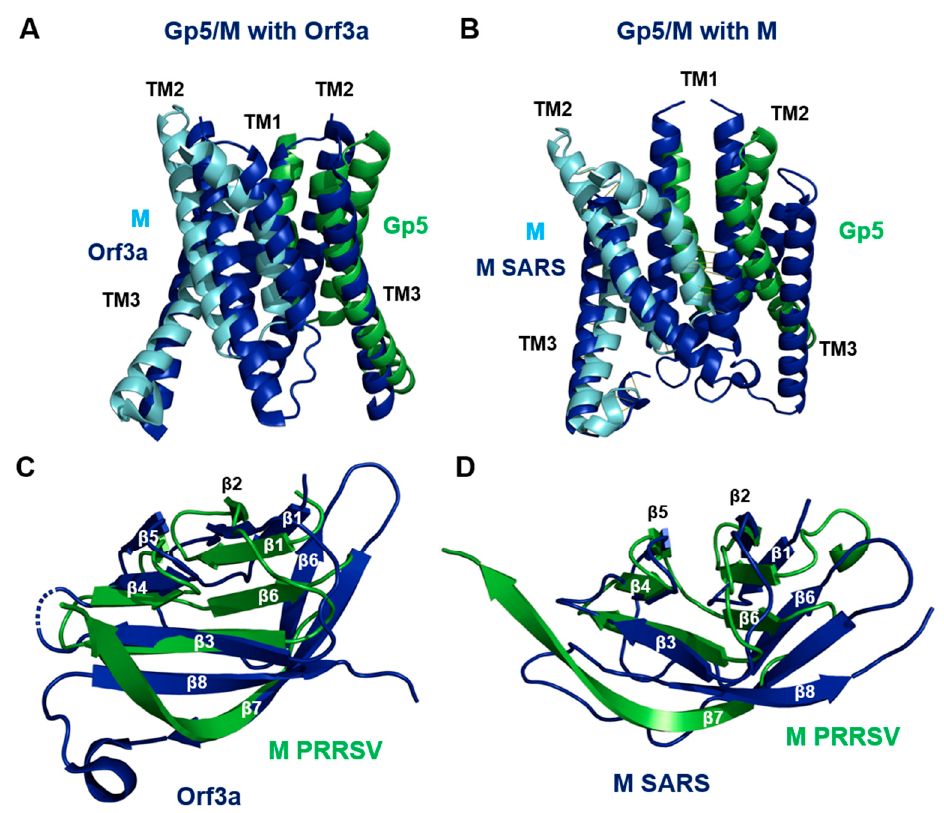
Figure 9. Alignment of the transmembrane regions of Gp5/M of PRRSV-2 with Orf3a ( A ) and with the long form of M ( B ) of SARS-CoV-2. Gp5 is colored green; M is colored cyan; and Orf3a and M of SARS-CoV-2 are colored blue. ( C , D ) Alignment of the endodomain of M of PRRSV-2 with one endodomain of Orf3a ( C ) or M ( D ) of SARS-CoV-2. M of PRRSV is colored green, and Orf3a and M of SARS-CoV-2 are colored blue. The transmembrane helices and β -sheets in the endodomain are numbered. Figures were created with Pymol from PDB-file 7VGR (M. long form) and 6XDC (Orf3a).